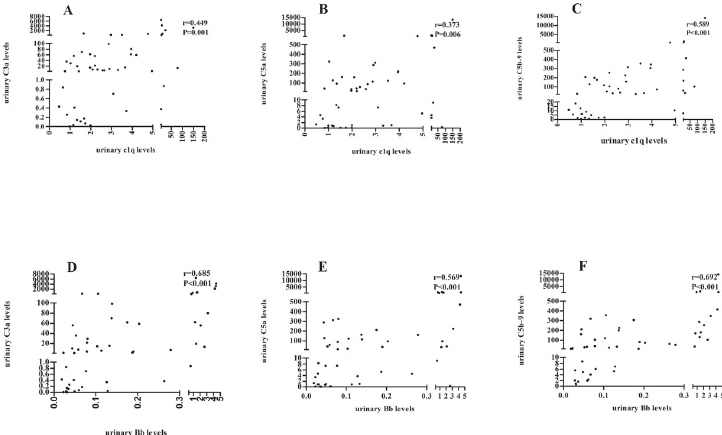
Fig 4. Correlations of urinary complement components in each patient. Urinary level of C1q was positively correlated with that of C3a (A), C5a (B) and C5b-9 (C). Urinary level of Bb was positively correlated with that of C3a (D), C5a (E) and C5b-9